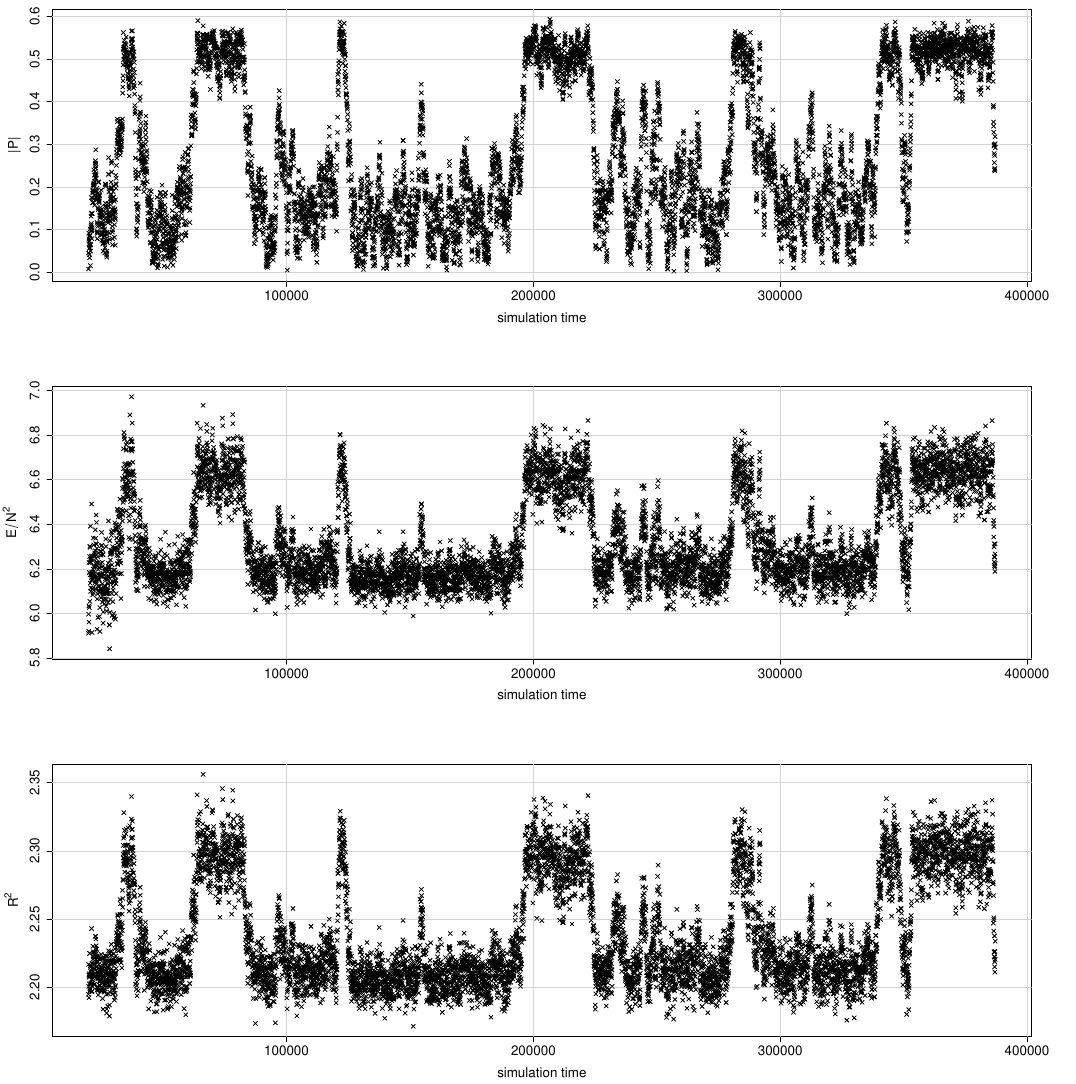
Figure 22. Simulation history for N = 64, L = 24, D = 10, T = 0 : 885. Only every 50th measure- ment is shown. Con(cid:12)gurations are dropped at the beginning to remove thermalization e(cid:11)ects. tion for a (cid:12)rst order transition. However, as emphasized in the main text, a detailed analysis including larger N and a continuum extrapolation is needed for a de(cid:12)nite conclusion.